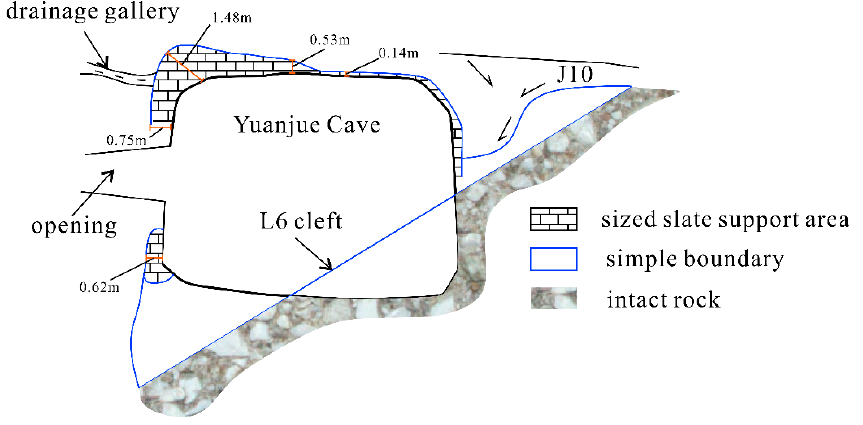
Figure 3. Development of internal slates and fi ssures in Yuanjue Cave